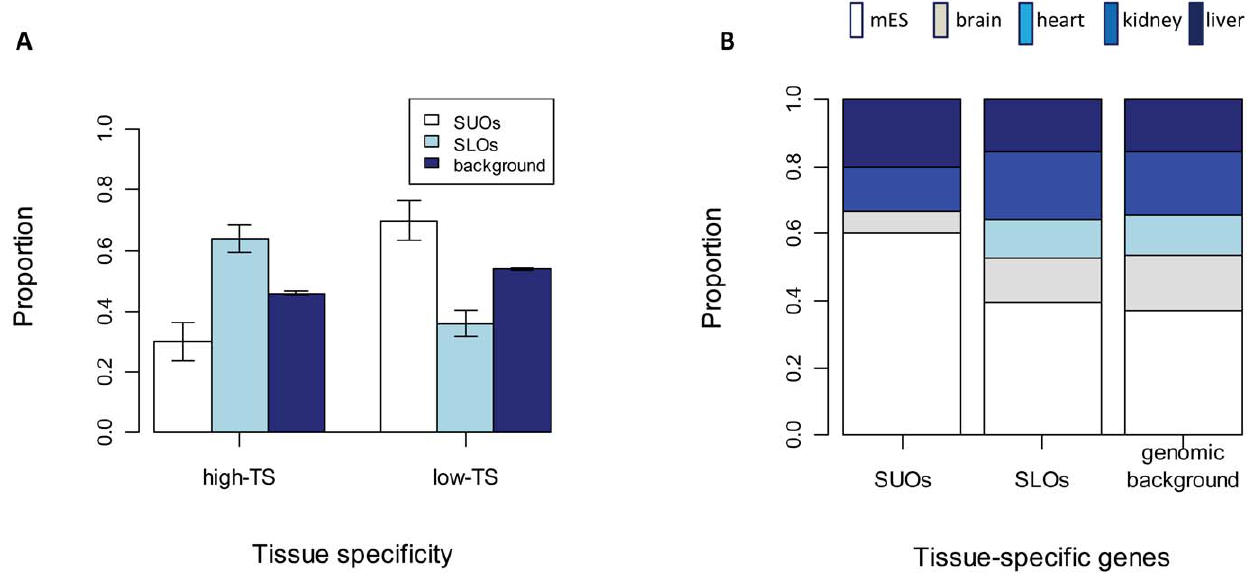
Figure 3. Tissue-specificity of Polr2a binding at outlier genes. (A) Associations between TE density and tissue-specificity of Polr2a binding. All gene sets are divided into two categories according to the Polr2a binding pattern of genes: the high tissue-specific (high-TS) and the low tissue- specific (low-TS). The proportions corresponding to the above two categories are shown for SUOs, SLOs and the genomic background as side-by-side bars. Error bars are standard errors derived from the total number of genes (sample size) in each gene set. (B) Tissue-type composition of SUOs/SLOs associated with strong Polr2a binding in only one tissue. For each gene set, the proportion taken by each tissue type is shown with corresponding color in a stacked bar. The ‘genomic background’ was calculated based on all mouse genes . 10 kb that show strong Polr2a binding in only one tissue. The color scheme for different tissue types is shown at the top.